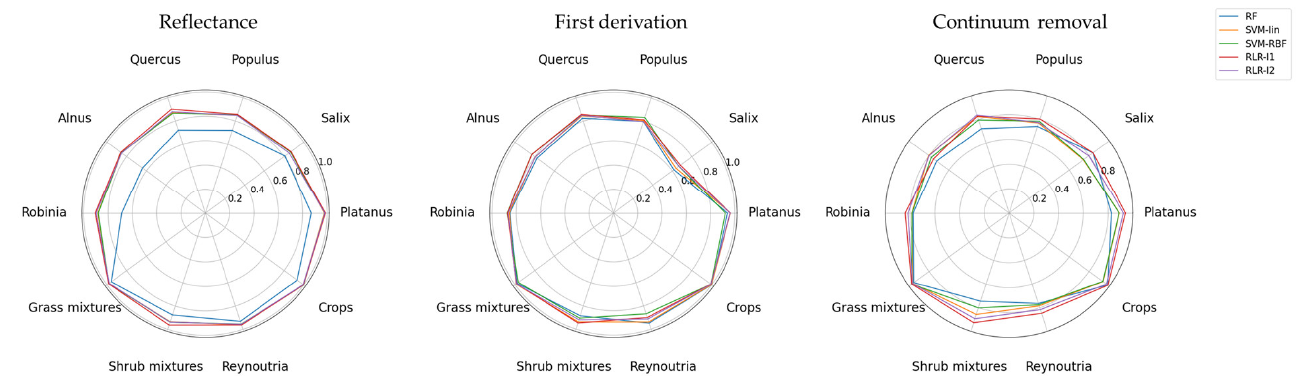
Figure 6. Average Overall Accuracy (AOA, in %; ± standard deviations) variations according to the selected component number with the RLR-ℓ1 algorithm for the three reduction techniques (PCA, MNF, and ICA).